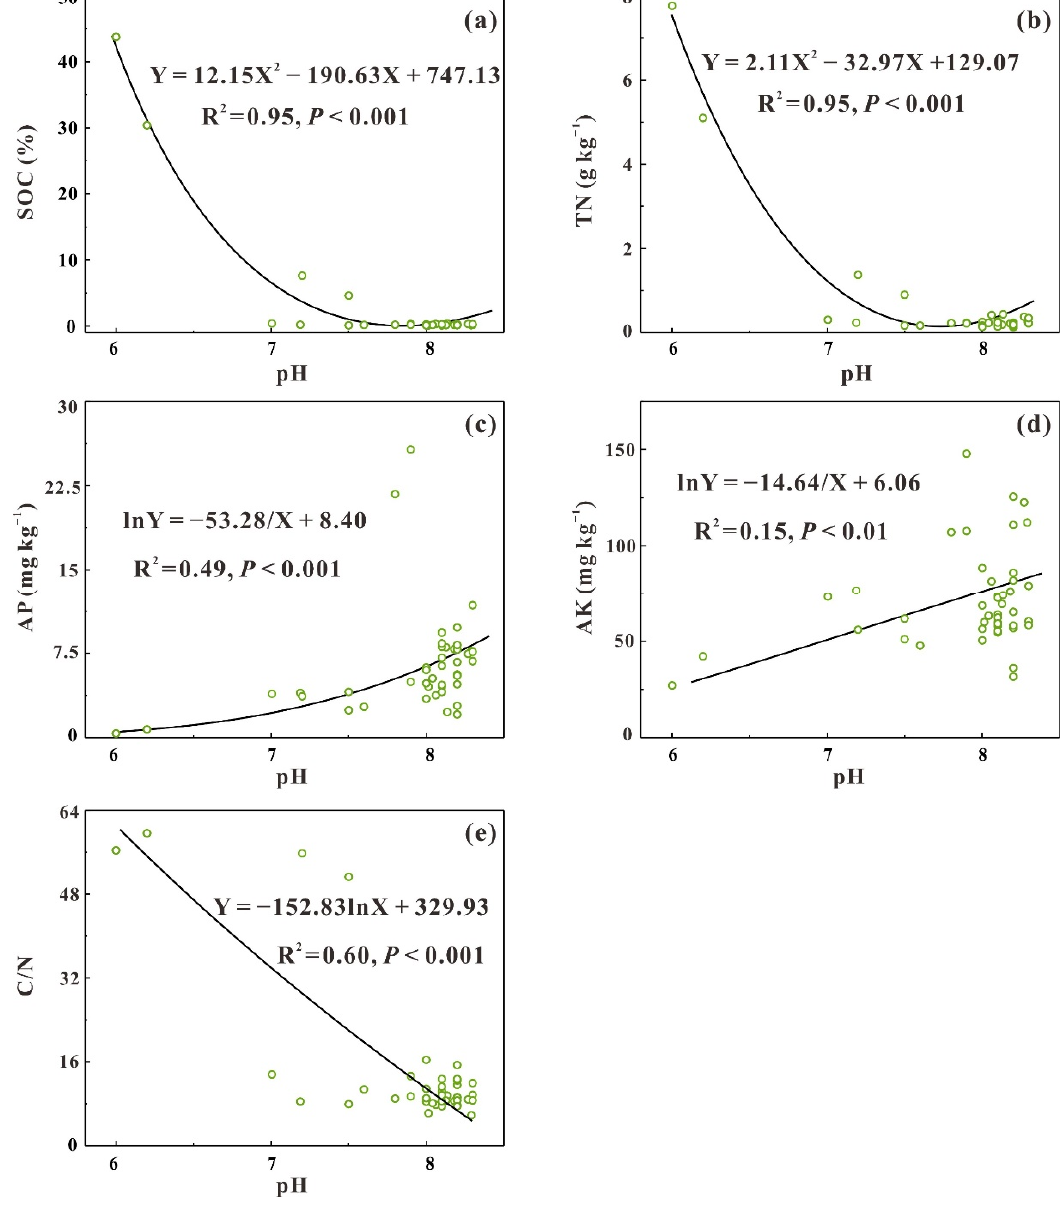
Figure 6. Results of regression analyses between soil pH and SOC ( a ), TN ( b ), AP ( c ), AK ( d ), and C/N ( e ). All coefficients and constants in regression equations are significant at 0.01 or 0.001 level.